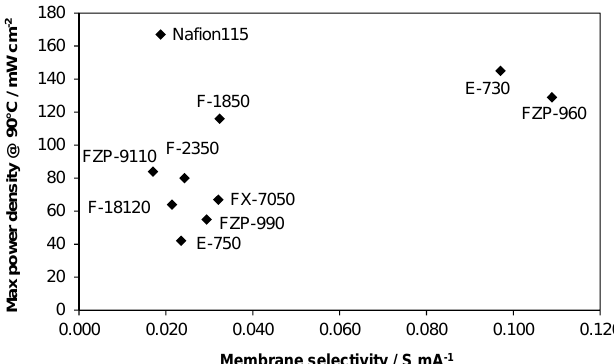
Figure 5. Performance vs. selectivity for MEAs equipped with different membranes at 90 °C (2 M MeOH).